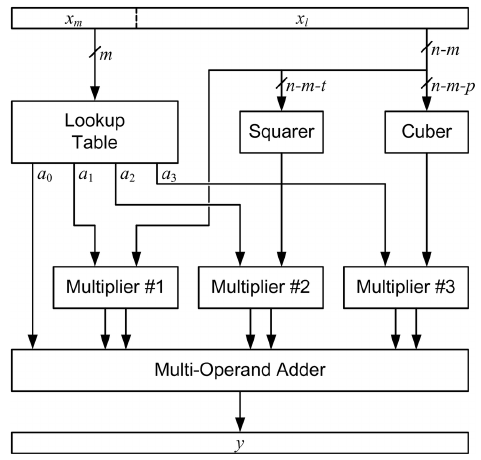
Figure 4. Cubic interpolator block